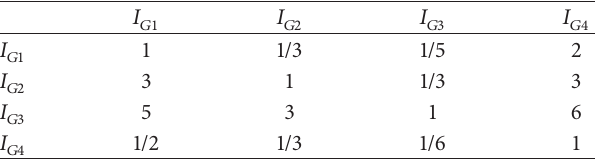
Table 9: Green development index judgment matrix of secondary indicators relative to primary